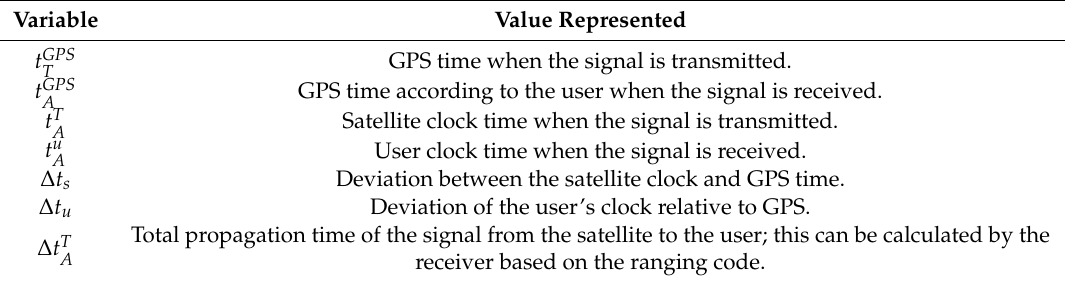
Table 1. Variables used for GPS time-transfer process calculations.